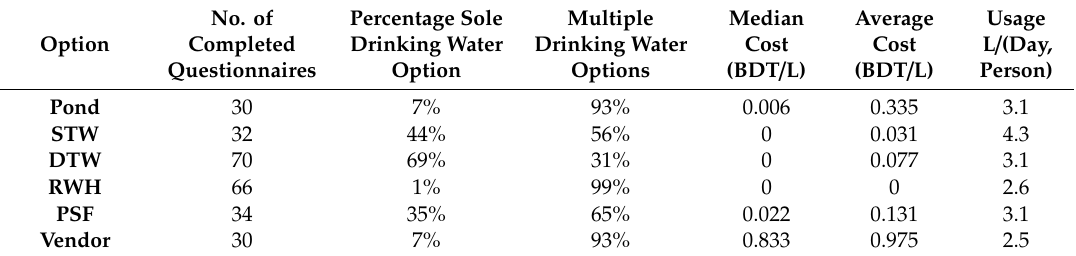
Table 2. General data for each drinking water option (1 USD = 84.5 BDT on 4 July 2019). STW = shallow tubewell, DTW = deep tubewell, RWH = Rainwater